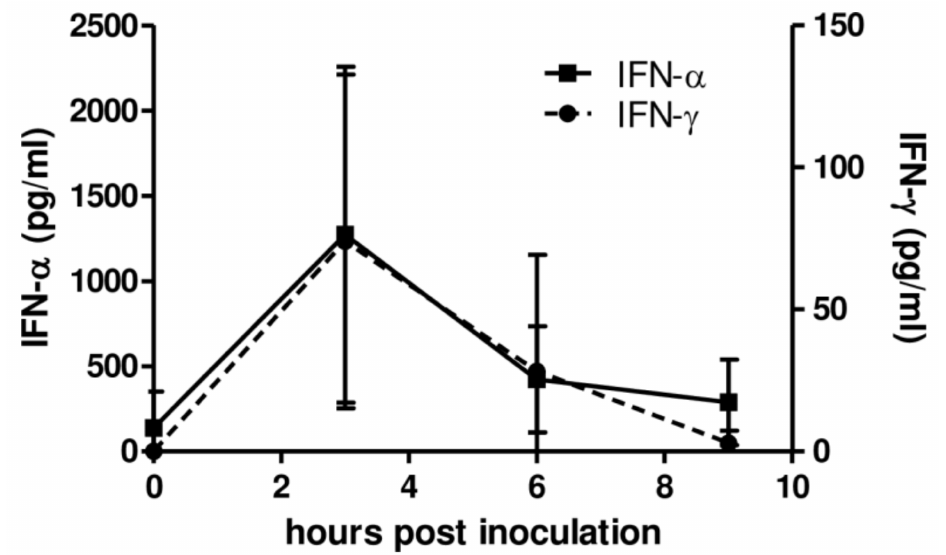
Figure 2. Type I and type II IFNs are detected in sera from AcMNPV-inoculated pigs. Five piglets were intravenously injected with 1 × 10 9 PFU of AcMNPV and serum samples were collected both before the administration and at 3, 6, and 9 hpi. IFN- α and IFN- γ levels in sera were quantified by